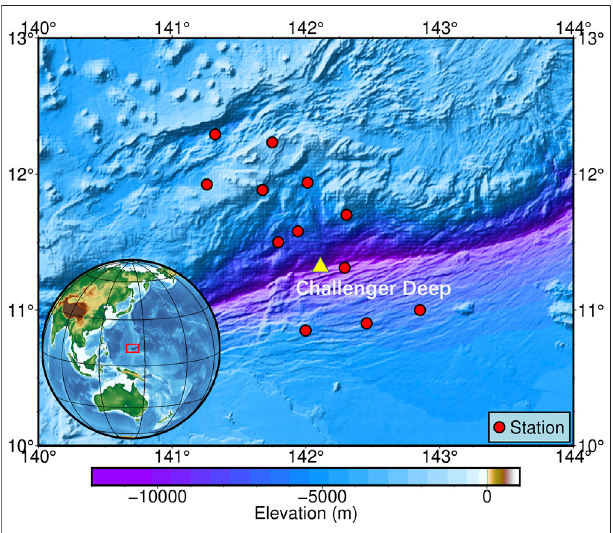
FIGURE 2 | The location of the array of 12 OBS stations. The yellow triangleisthelocationoftheChallengerDeep.Thebottom-leftinsetrepresents the location of our study